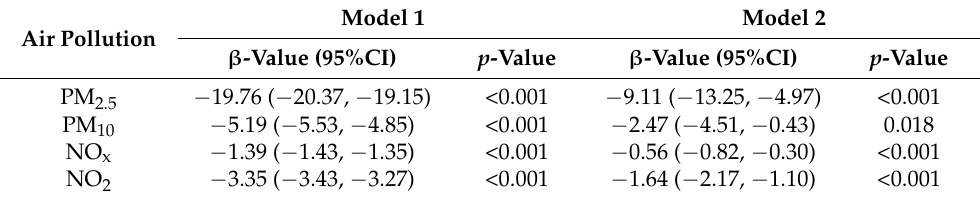
Table 2. Associations of air pollution and Vitamin D.